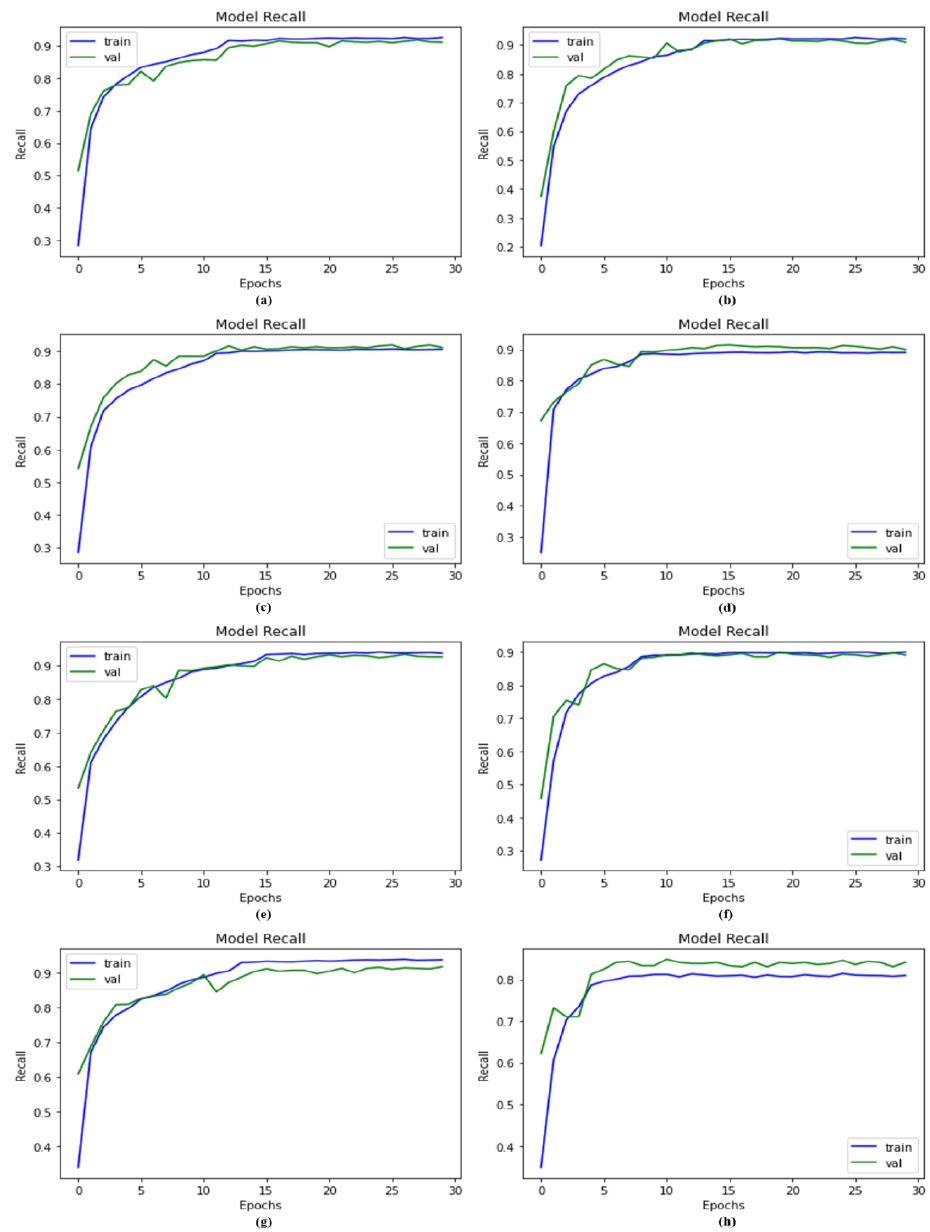
Figure 9. The recall analysis measures the proportion of true positive results correctly identified by a predictive model out of all actual positives; ( a ) Vgg-16, ( b ) Vgg-19, ( c ) EfficientNet-B0, ( d ) ResNet-152, ( e ) Inception-V3, ( f ) MobileNet, ( g ) Proposed Model with SMOTE Tomek, and ( h ) Proposed Model without SMOTE Tomek.